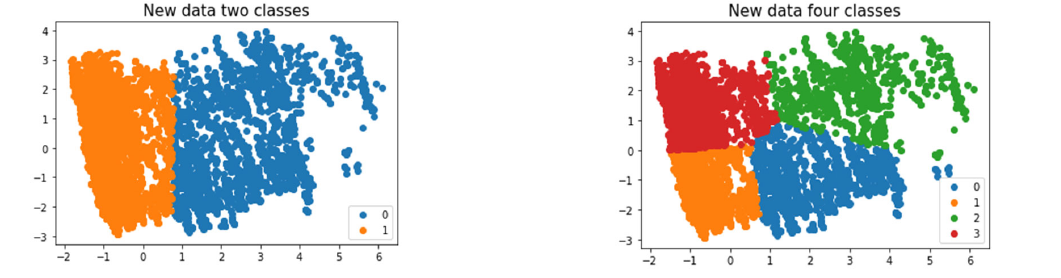
Fig. 13. The new data format was divided into two classes Fig. 14. The new data format was divided into four classes